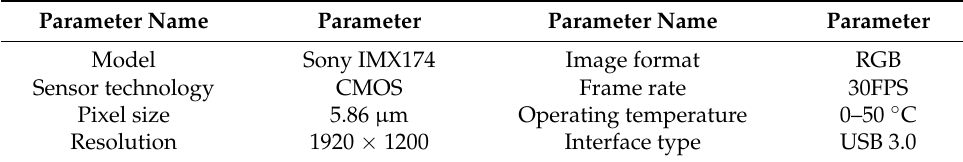
Figure 3. Tracking module installation location diagram. Table 1. Industrial camera-specific parameters.